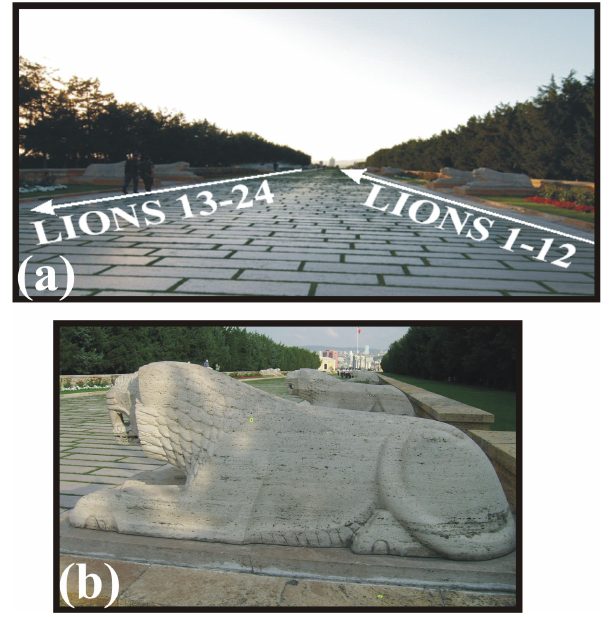
Fig. 2. Lion statue group including 24 lions sitting on what is called the Lion Road at Anitkabir.